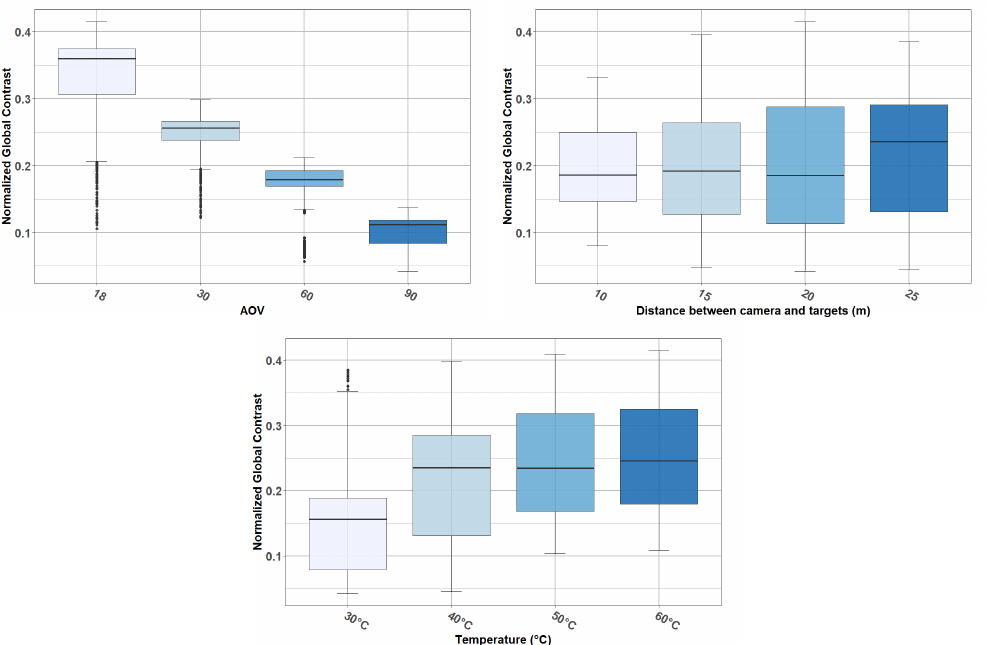
Figure 15. Reference data: contrast distribution according to AOV, camera-to-target distance, and